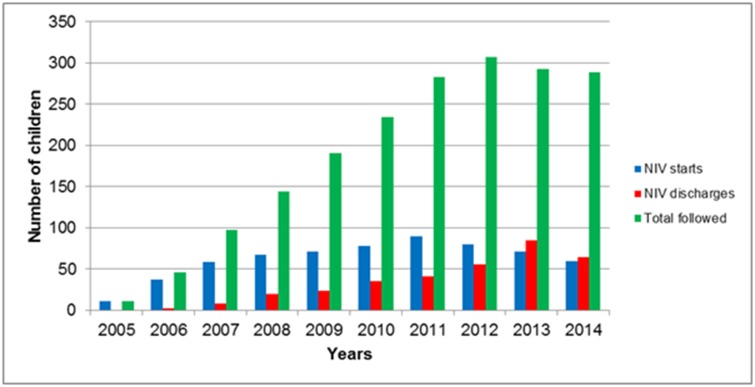
New NIV starts, discharges and total number of children followed by the NIV programs.NIV, non-invasive ventilation.